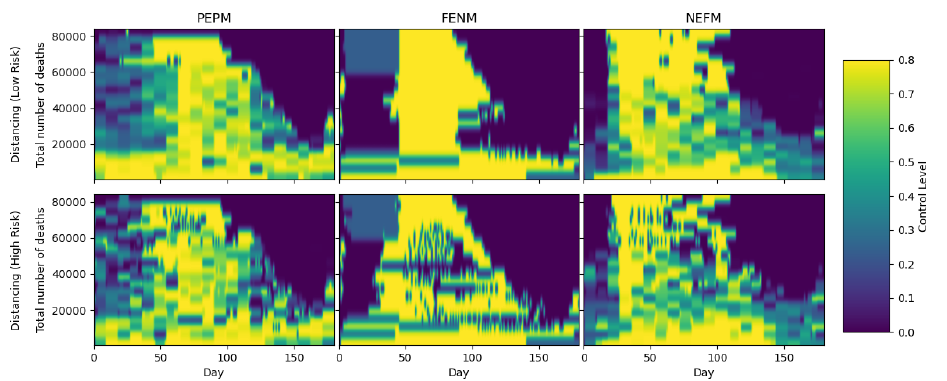
Figure 5. Social distance control measures corresponding to the Pareto-optimal solutions in Figure 2. The first row of figures shows the daily progression of low-risk distancing control levels for PEPM, FENM, and NEFM for Pareto optimal strategies that attain different overall deaths, as indicated on the y -axis of the graphs. The second row shows corresponding figures for high-risk distancing levels for the PEPM, FENM, and NEFM